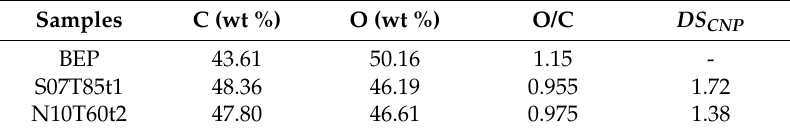
Table 3. Elemental analysis of BEP and PeM-CNP